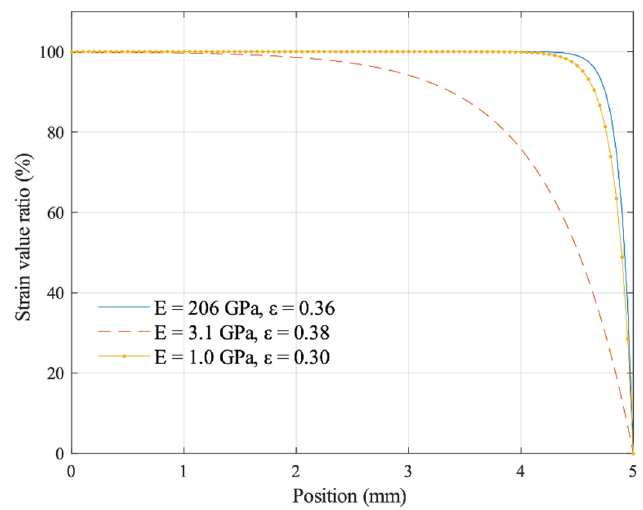
Figure 6. Strain distribution at different positions along the thickness direction. The strain value ratio is obtained from the strain inside the strain gauge and the elastomer.